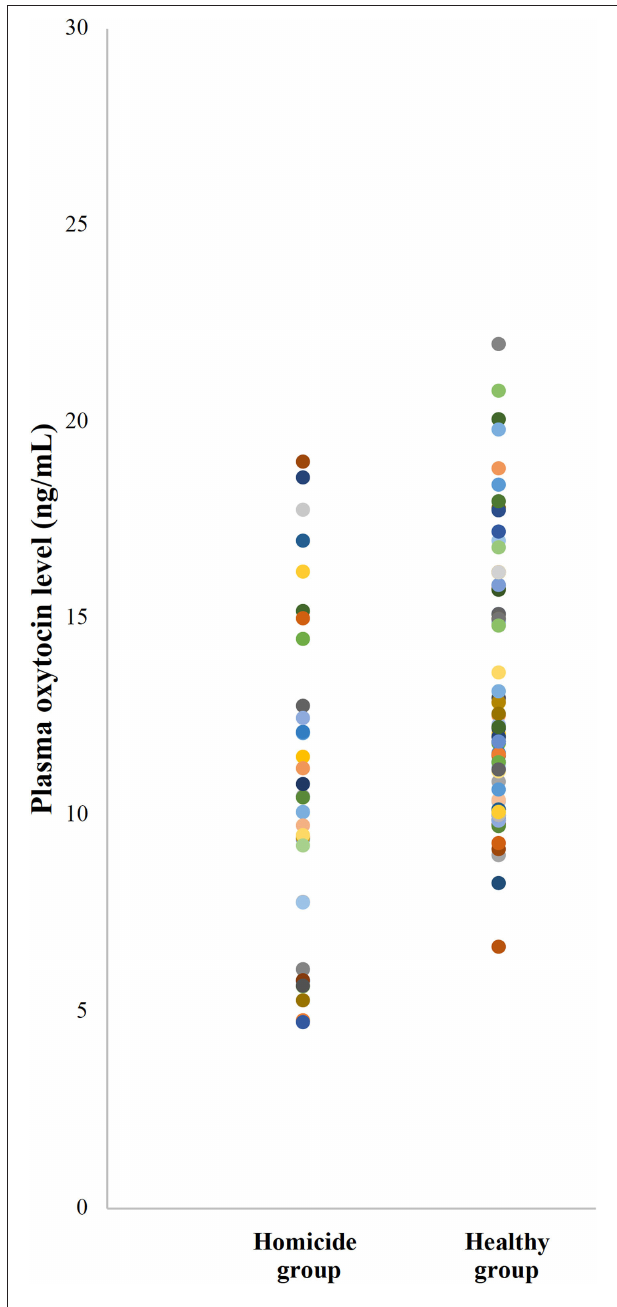
FIGURE 1 | Scatter plot illustrating the plasma oxytocin levels of participants in homicide groups and healthy groups. Each color dot represents the plasma level of oxytocin of each